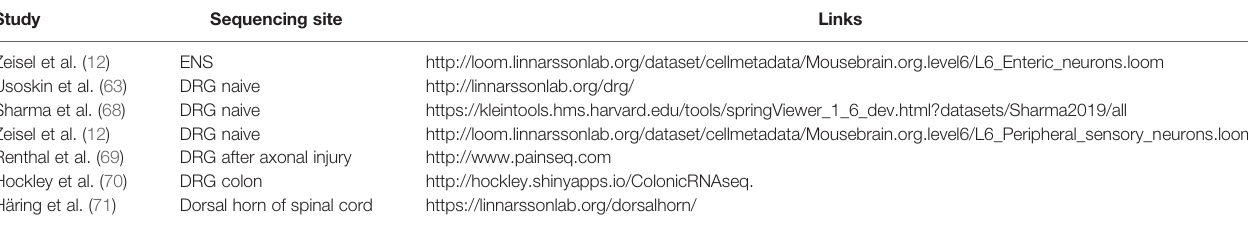
TABLE 2 | links to access the respective